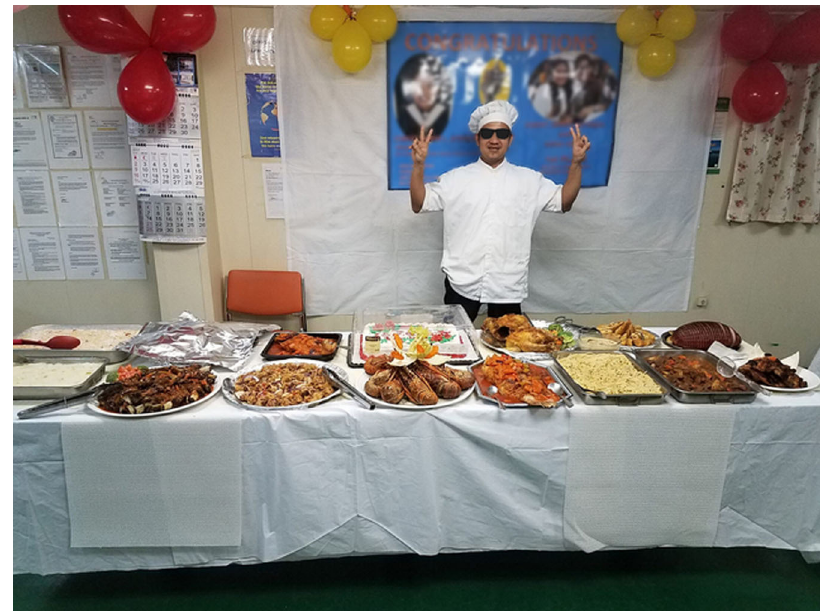
Fig. 9 Celebratory Dinner. Photograph was taken by participant of a celebration.